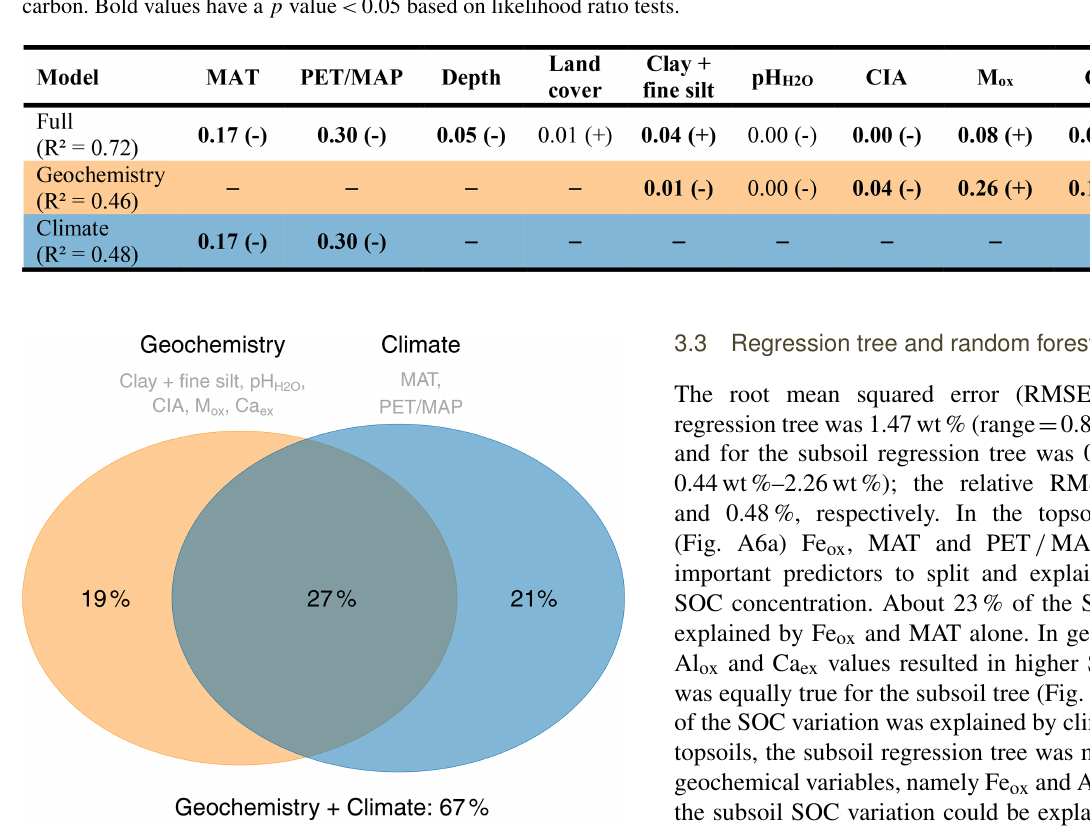
Table 3. Marginal R 2 for each predictor based on sequential fitting of the linear mixed-effects models of all samples ( n Total = 1601) for the full, geochemistry-only and climate-only models. The sign in parentheses refers to the correlation between the predictors and soil organic carbon. Bold values have a p value < 0.05 based on likelihood ratio tests.